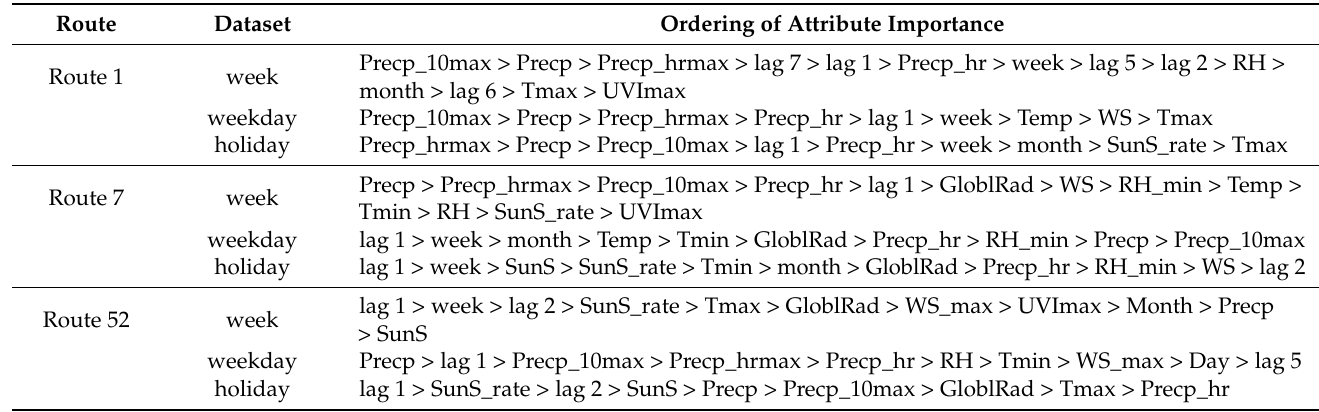
Table 9. Key attributes of bus routes for different time data.